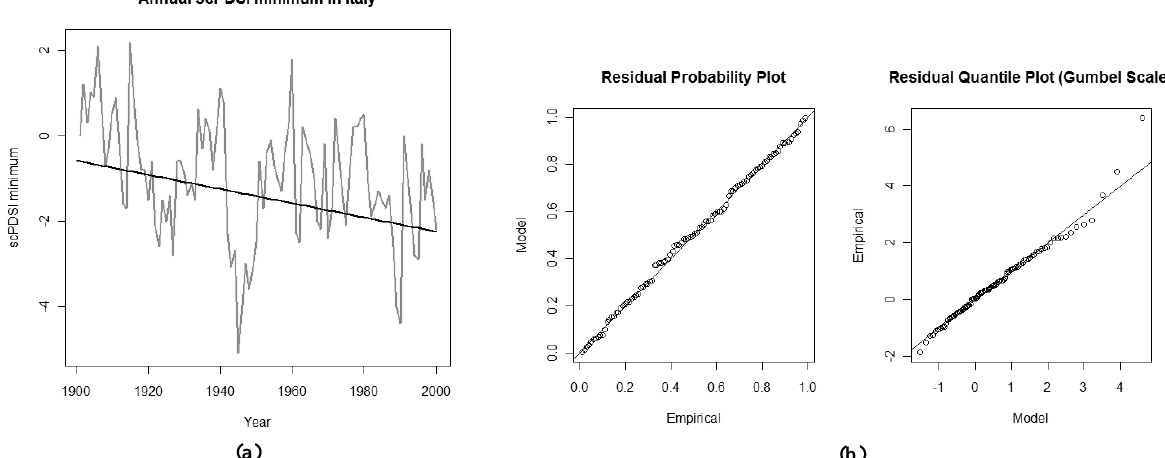
Fig. 8. (a) Annual scPDSI minimum in the Italian Peninsula; (b) residual diagnostic plots in linear trend GEV model of Italian Peninsula minimum scPDSI